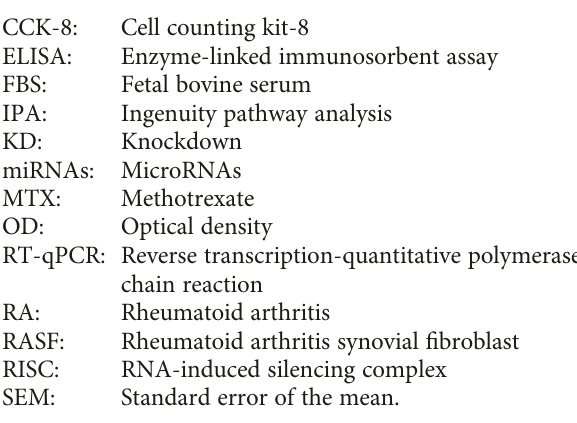
Fig. S1: information of DICER1 overexpression plasmid. (A) Map of DICER1 overexpression plasmid (pCAGGS plasmid carrying full-length CDS). (B) Characteristics of plasmid car- rying human DICER1 full-length CDS. Fig. S2: DICER1 mRNA and protein expression in TLR2,3,4,7 ligand or proin fl ammatory cytokine stimulated SW982 human syno- viocytes. (A, B) Western blotting (A) and semiquantitative RT-PCR (B) of DICER1 expression in 10 ng/ml PGN (TLR2 ligand), 10 μ g/ml poly I:C (PIC, TLR3 ligand), 10 ng/ml LPS (TLR4 ligand), 3 μ g/ml imiquimod (TLR7 ligand), and in fl ammatory cytokines including 100 ng/ml recombinant human IFN- γ , 10 ng/ml recombinant human IL-4, 10 ng/ml recombinant human TNF- α , and 10 ng/ml recombinant human IL-1 β -stimulated SW982 cells for 0, 6, 12, 24, and 48 h. Representative image from three indepen- dent cell experiments was shown. GAPDH was chosen as endogenous control for expression normalization during both the RNA and protein detection. Fig. S3: representative FACS imaging for altered apoptosis caused by gain or loss of DICER1 function for 48 h in SW982 human synoviocytes. (A) Altered apoptosis caused by loss of DICER1 function. (B) Altered apoptosis caused by gain of DICER1 function. Representative double staining of Annexin V-FITC and PI was displayed using scatter plots to discriminate the early, mid-late phase of apoptosis. Annexin V-FITC-positive cell percentage was analyzed for the apoptotic cell ratio. Mean ± SEM of data were analyzed from three independent transfection experiments; triplicates were used for each